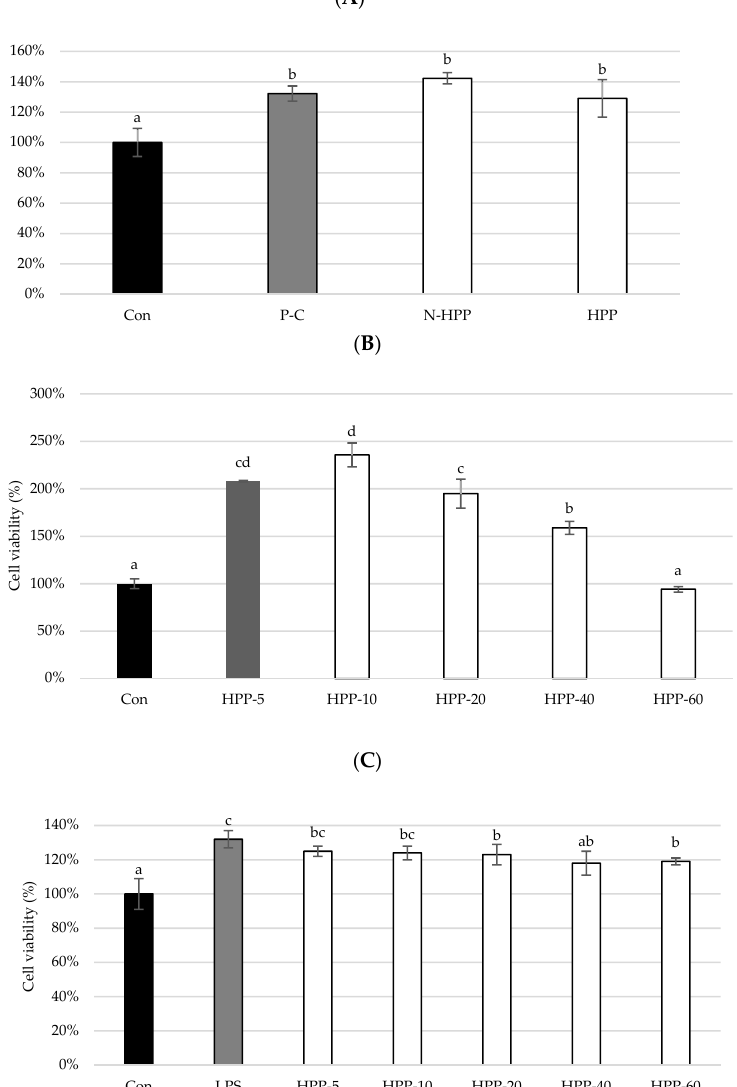
Figure 3. Cell survival rate. ( A ) Effects of the untreated group and high-pressure treated group. ▓ Con: control (not LPS induced); ▓ P-C: positive control (LPS induced); □ N-HPP: LPS induction + Non HPP untreated group; □ HPP: LPS induction + high-pressure group, 400 MPa, 15 min. ( B ) Effects of the broccoli extracts of different SFN concentrations without LPS induction. ▓ Con: Control; □ HPP-5 (not LPS induced + 5 ppm broccoli extract). ( C ) Effects of the broccoli extracts of different SFN concentrations. ▓ Con: control (not LPS induced); ▓ LPS:(LPS induced); □ HPP-5 (LPS induced +5 ppm broccoli extract). All data are presented as the mean ± SD ( n = 3). Different letters in the same row indicate significantly different results ( p < 0.05).